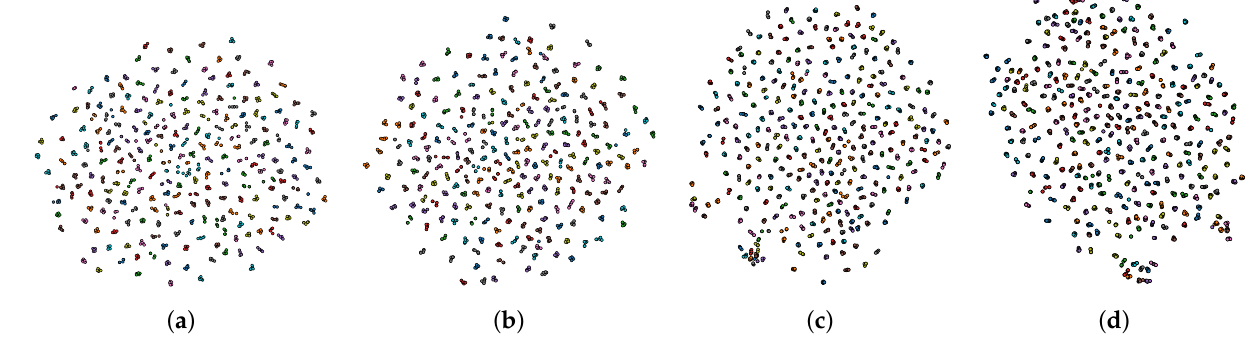
Figure 14. 2-D t-SNE visualization of the learned palmprint embeddings for sample images from the ( a ) IITD left, ( b ) IITD right, ( c ) CASIA left, and ( d ) CASIA right palmprints. Note that the combination of the learning objectives results in well separated and compact class clusters. The figure is best viewed electronically and